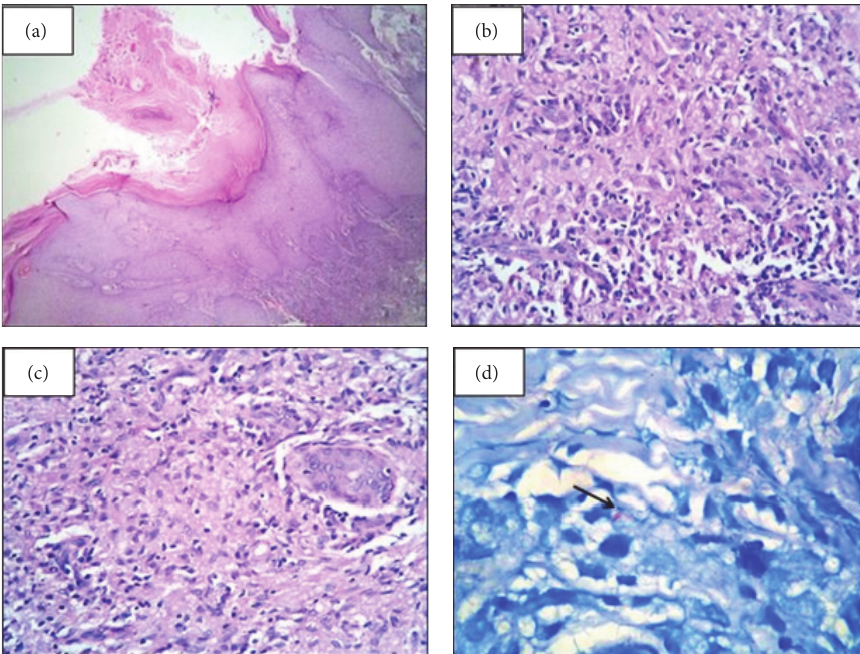
Figure 3: (a) Wedge biopsy from the verrucous lesion on the right ankle shows hyperkeratosis and parakeratosis with irregular acanthosis of the epidermis (H&E, 40x). (b) and (c) Dermis shows epithelioid cell granulomas along with lymphocytes and plasma cells (H&E, 400x). (d) Arrow shows positivity for acid fast bacilli (ZN stain,